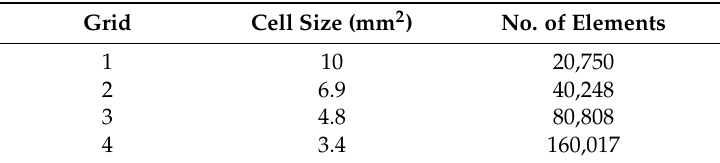
Table 5. Grid density